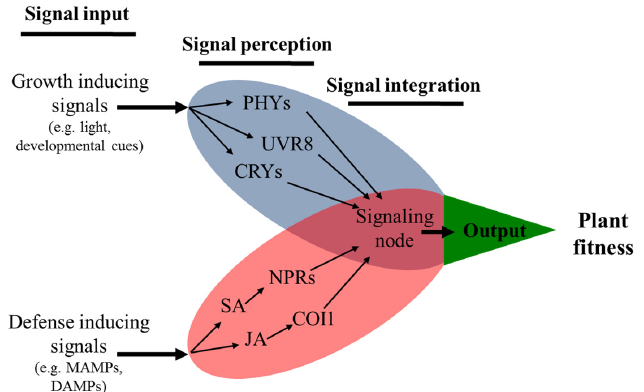
Figure 2. Environmental cues are perceived and integrated through light and defense signaling to appropriately drive plant growth and defense processes. Proposed model of the integration of growth and defense signals, whereby a signaling node integrates multiple signals perceived from the environment to define the plant phenotype (output), which will ultimately determine plant fitness. The nature of the signal elicits different receptors (signal perception) to trigger signaling cascades that are integrated by molecular players acting as nodes of integration. The final plant phenotype is determined by the degree of activation and repression of specific molecular pathways.